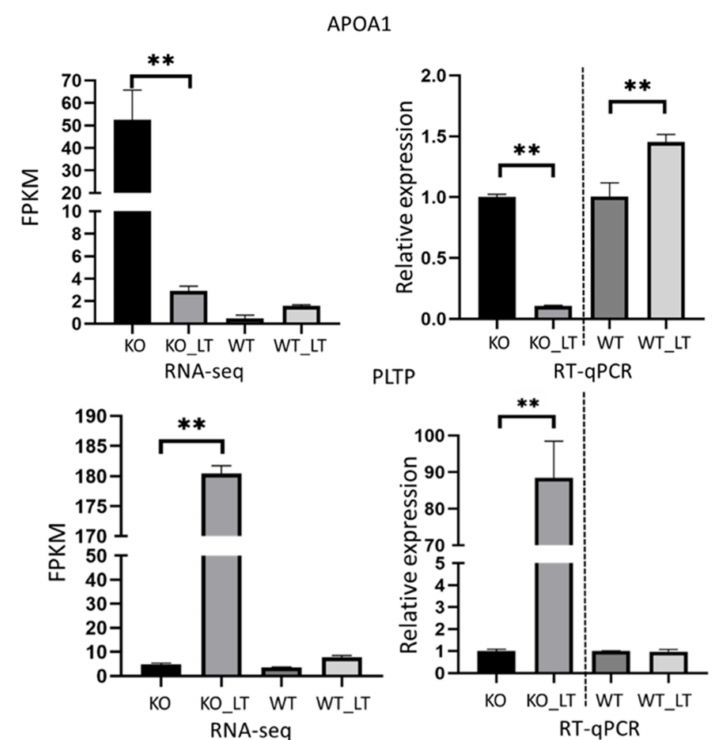
Figure 6. Expression levels of APOA1 and PTLP in RNA-seq and RT-PCR. ** p <